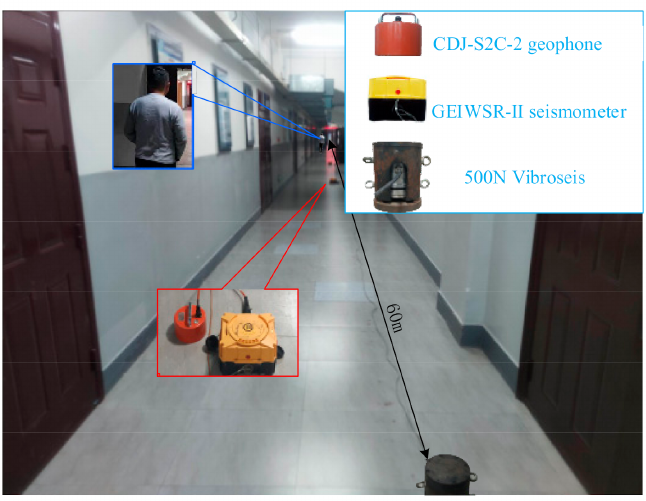
Figure 5. The distribution of 5 CDJ-S2C-2 geophones, 5 GEIWSR-II seismometers and a 500 N vibroseis